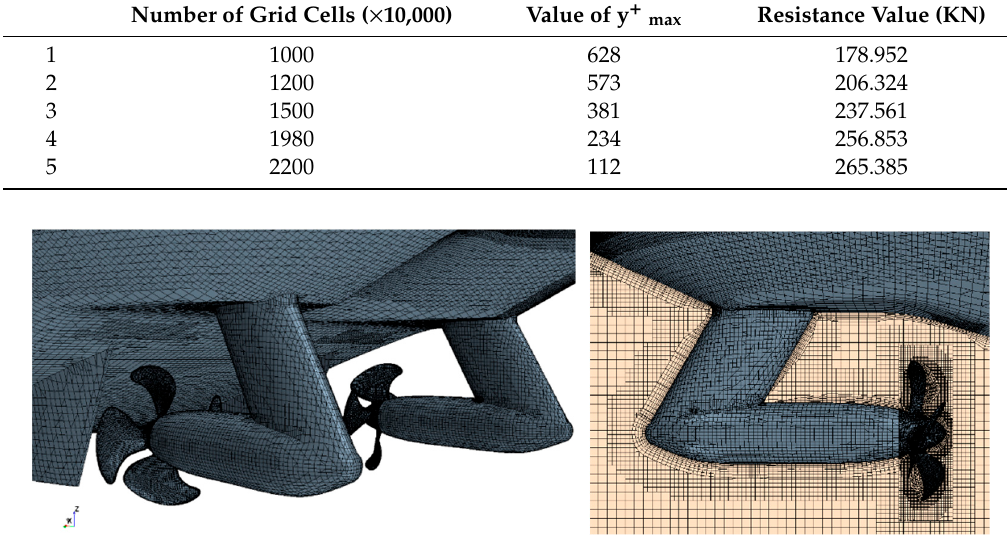
Figure 6. Mesh of a full-scale ship.